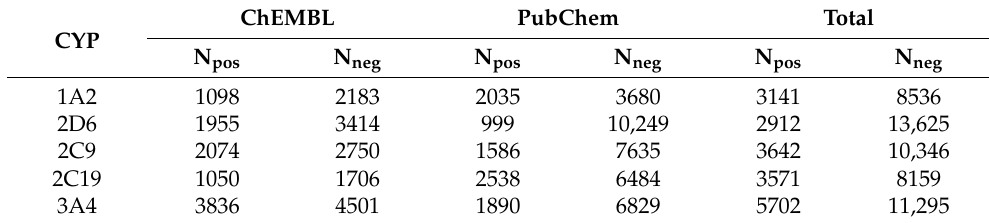
Table 4. Characteristics of the training sets for development of classification models. CYP